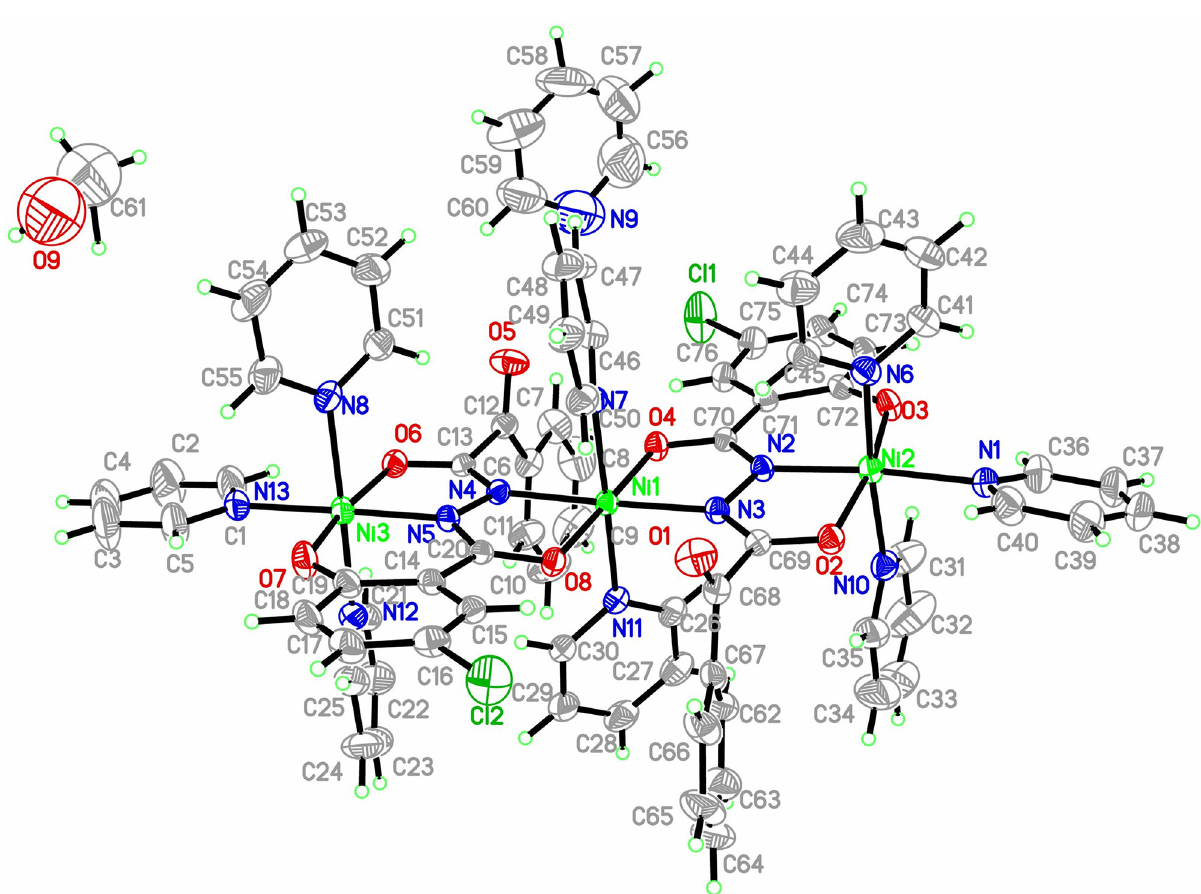
The crystal structure is shown in the figure. Table 1 con- tains crystallographic data and Table 2 contains the list of the atoms including atomic coordinates and displacement